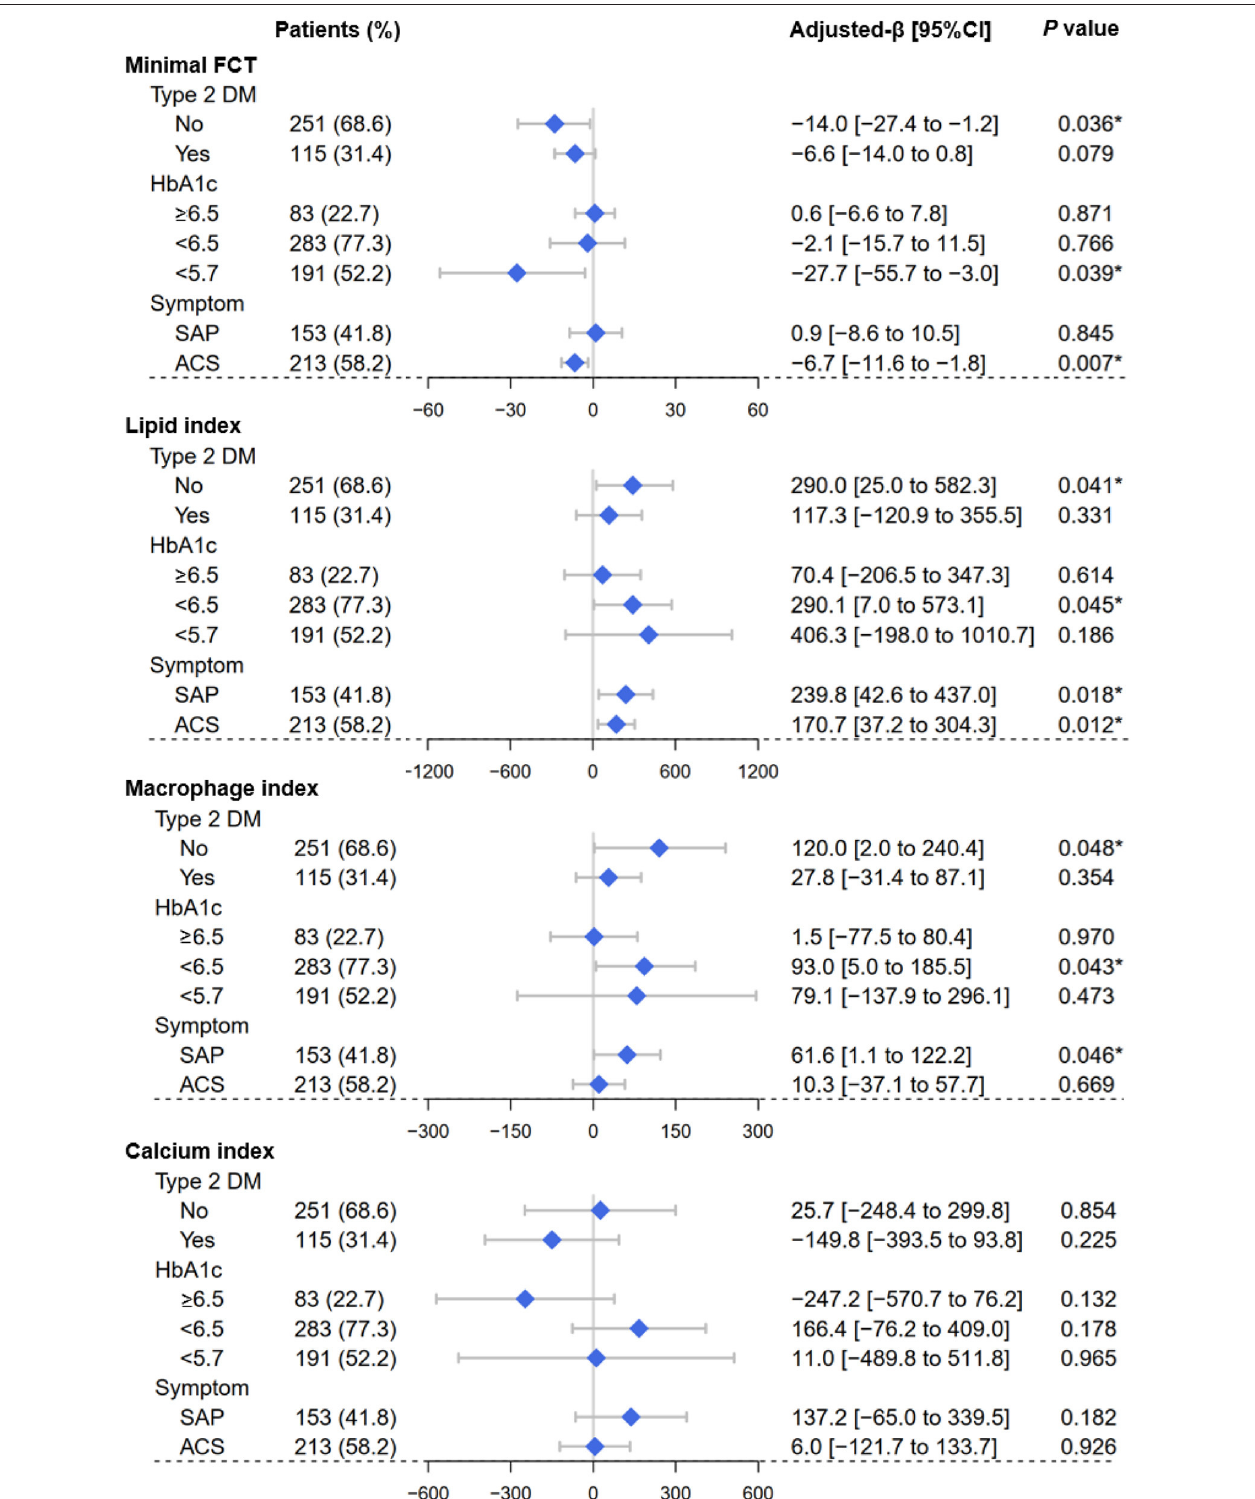
FIGURE 4 | Forest plots of the vulnerability feature analyses. By using OCT assessment, forest plots depicted the effect of pre-procedure HbA1c levels on the vulnerability feature of culprit vessels, including minimal fibrous cap thickness, lipid index, macrophage index, and calcium index. Subgroups were determined according to Type 2 DM (yes or no), HbA1c categories ( < 5.7%, 5.7–6.4%, ≥ 6.5%), clinical symptom (SAP or ACS). OCT, optical coherence tomography; SAP, stable angina pectoris; ACS, acute coronary syndrome; FCT, fibrous cap thickness; DM, diabetes mellitus. * P < 0.05.